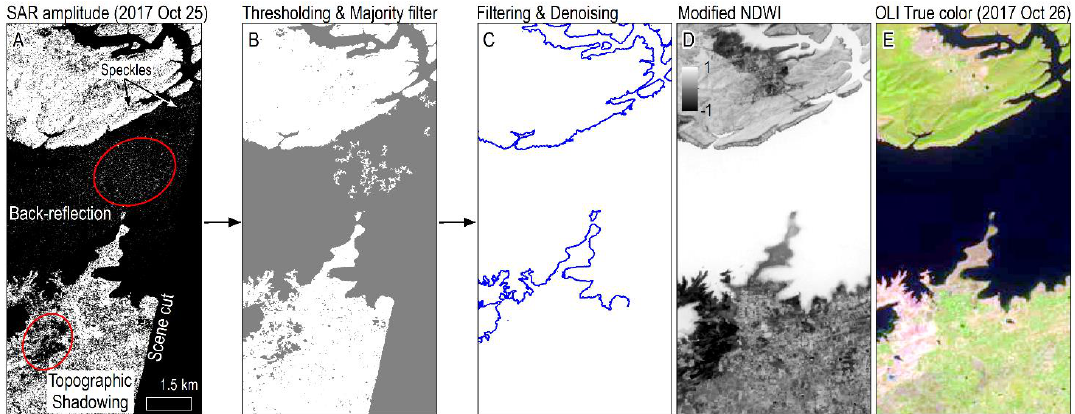
Figure 2. Filtering and de – noising process developed in this study (using a portion of